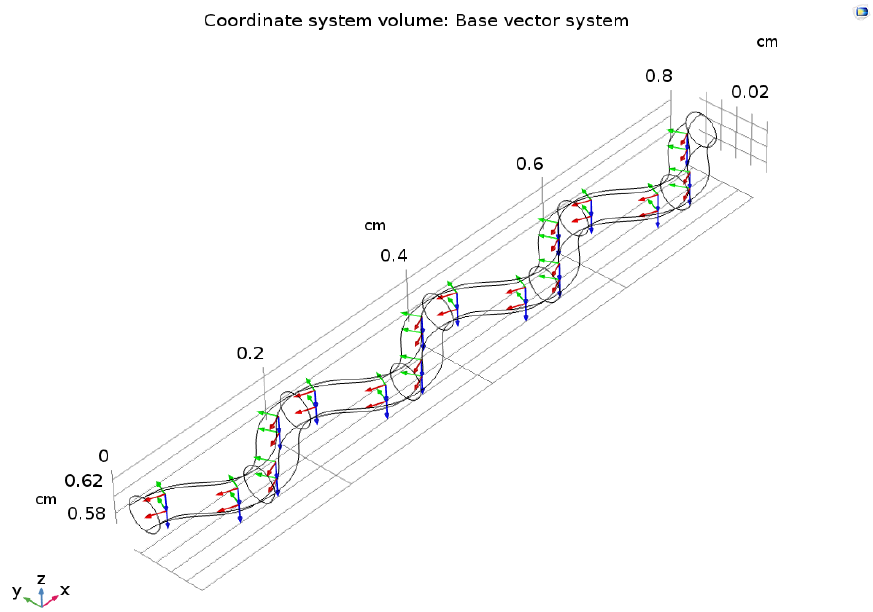
Figure 3. A three-dimensional curvilinear coordinate system for a single fiber.